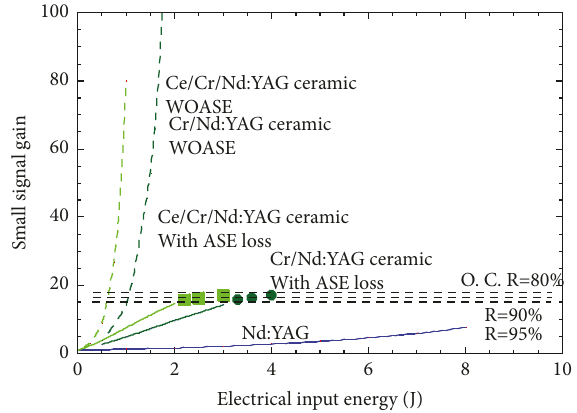
R=95%R=90%O. C. R=80%